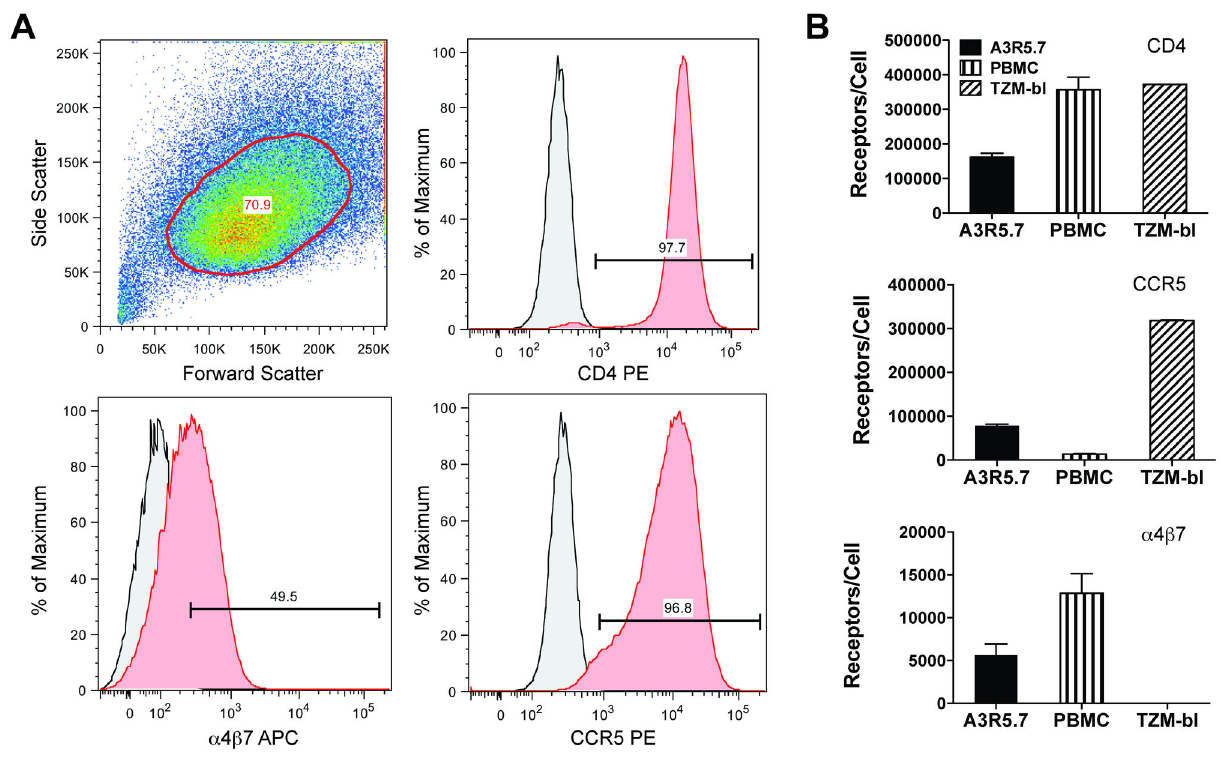
Figure 2. Receptor expression in A3R5.7 cells. A. Flow cytometric analysis of CD4, CCR5 and α β expression in the 4 7 A3R5.7 cell line. 0.5 x 10 6 cells were singly stained for 30 minutes with fluorochrome-conjugated antibodies as shown followed by fixation in 2% paraformaldehyde. Data are representative of at least two independent experiments. Isotype controls are shown in grey. Nearly all cells were positive for CD4 and CCR5 while approximately half were positive for α β . B. Comparison of cell 4 7 surface CD4, CCR5 and α β receptor densities in various cell targets. 0.5 x 10 6 cells were stained with fluorochrome- 4 7 conjugated antibodies and compared to defined populations of similarly stained Quantum Simply Cellular beads. PBMC were stimulated with CD3.8 bi-specific antibody in the presence of 50U/mL rhIL-2. Assuming monovalent antibody-to-surface receptor binding, the Antibody Binding Capacity (ABC) calculated is equivalent to receptors/cell. Data represents the mean of two separate experiments. TZM-bl cells express high levels of CD4 and CCR5 but are negative for α β while A3R5.7 cells possess CCR5 and 4 7 α β densities more similar to PBMC. CD4 expression on TZM-bl was beyond assay range. 4 7 doi: this virus in all three cell targets at or near the lowest cell lines compared to TZM-bl (Figure 3D)(Mann-Whitney test; concentration tested (0.78 μg/mL)[29,32]. Neutralization by the p<0.001). gp41-specific 2F5 and 4E10 mAbs was slightly more potent in A3R5.7 cells than either TZM-bl or stimulated PBMC. However, the IC of the gp120 competitive inhibitor sCD4 was 50 significantly lower in the A3R5.7 line (unpaired t-test; p<0.05) compared to both TZM-bl and PBMC. In Figure 4B, neutralization sensitivity to pooled sera/plasma from three different subtypes and from a subtype-matched (AE) HIV+ individual plasma was markedly greater in the A3R5.7 line versus TZM-bl and stimulated PBMC. However, the difference only reached significance (unpaired t-test; p<0.03) for the subtype B pool when comparing A3R5.7 vs. TZM-bl.